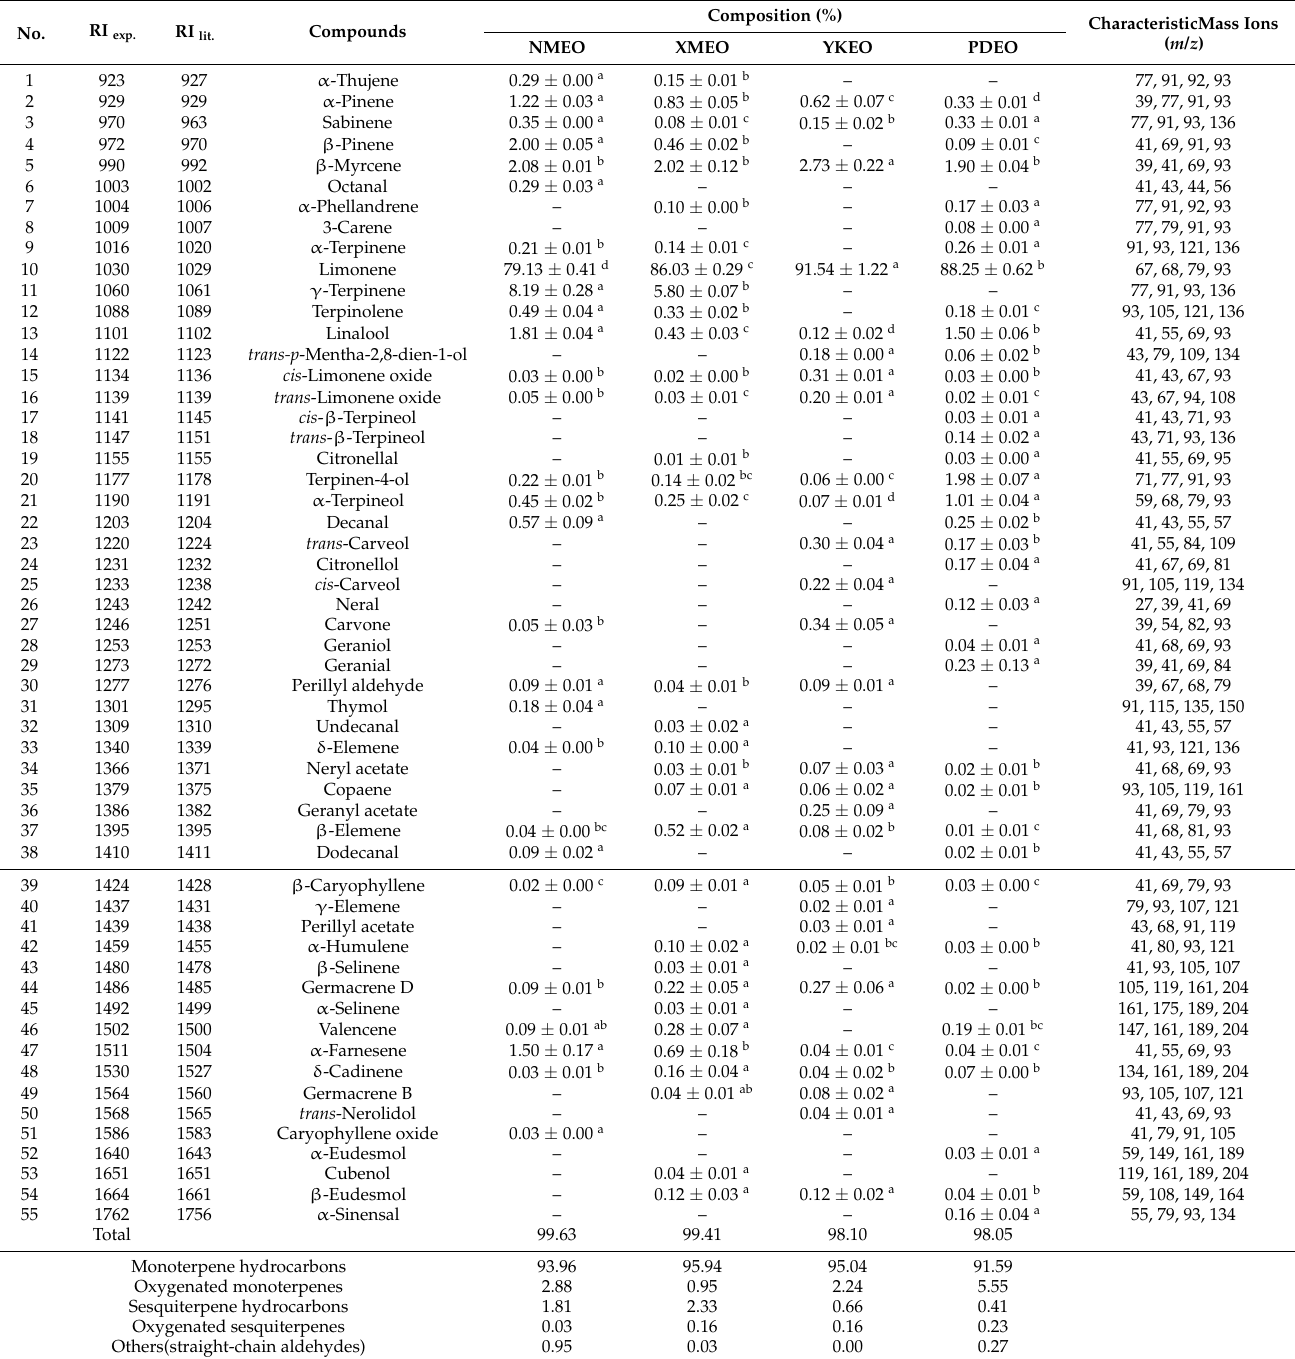
Table 1. Chemical compositions of the citrus EOs as found by